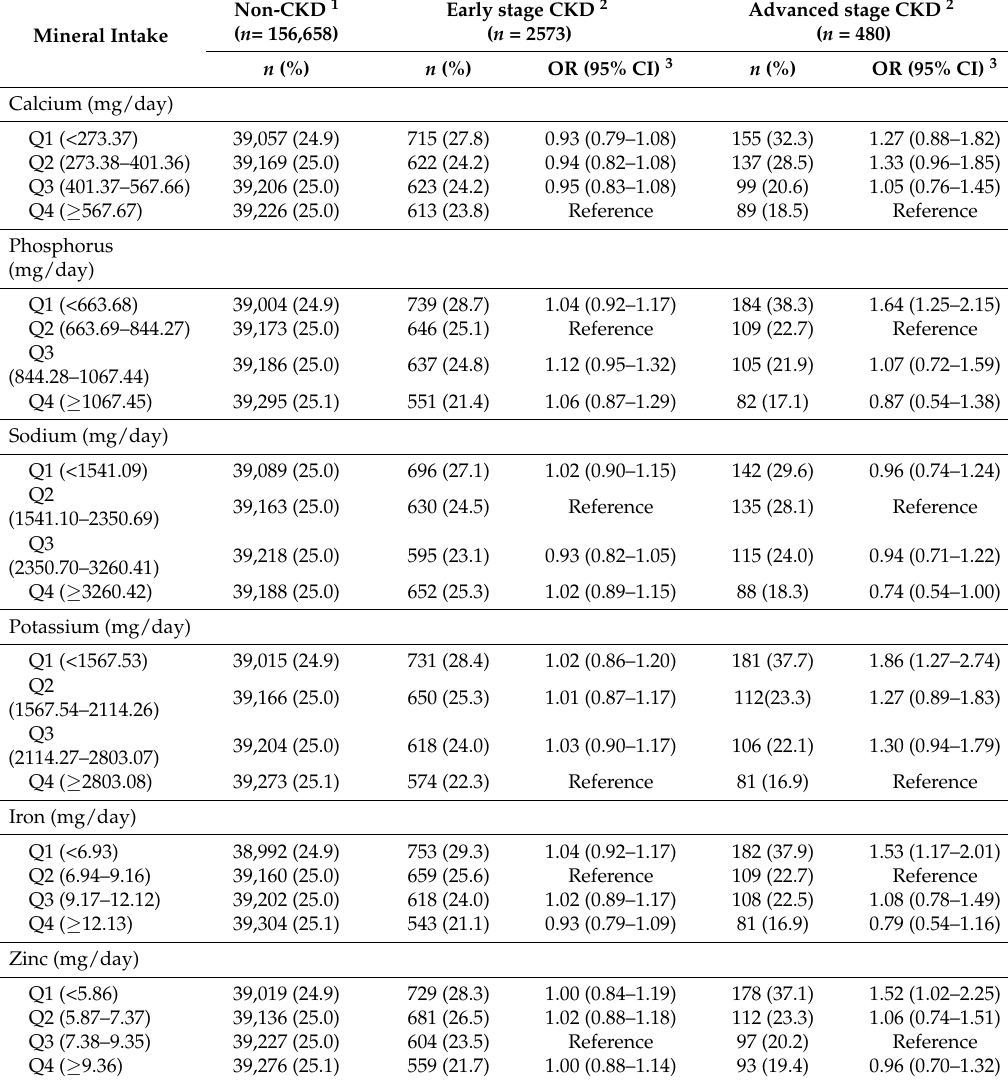
Table 2. Association between dietary mineral intake and CKD in the Health Examinees (HEXA) study of the Korea Genome and Epidemiologic Study (KoGES),